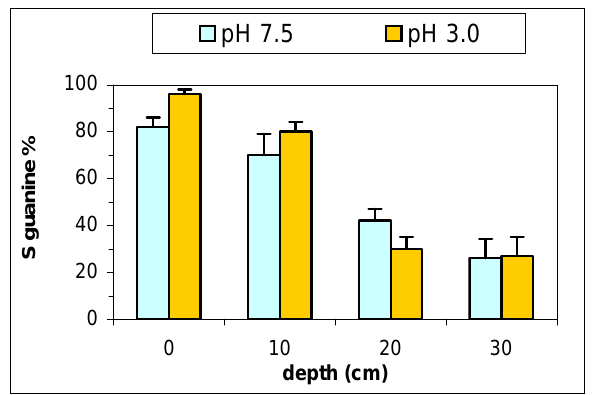
Figure 6. DNA biosensor results for different depths in zone 4 of hill n°5 in ACNA area (sampling of 2003). Extraction